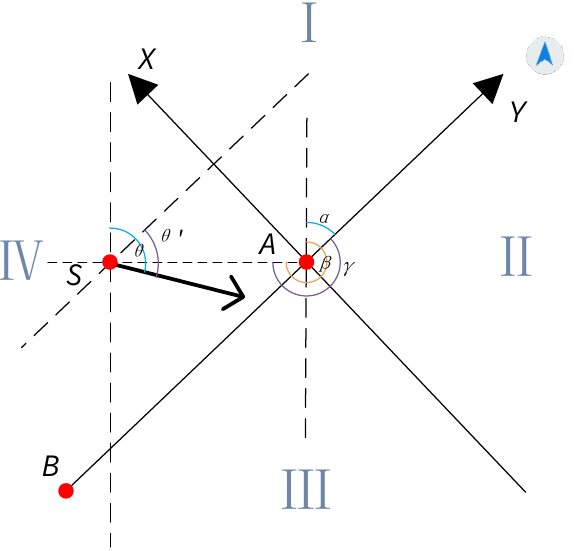
Figure 3. The new coordinate system established according to the direction and position of survey lines.